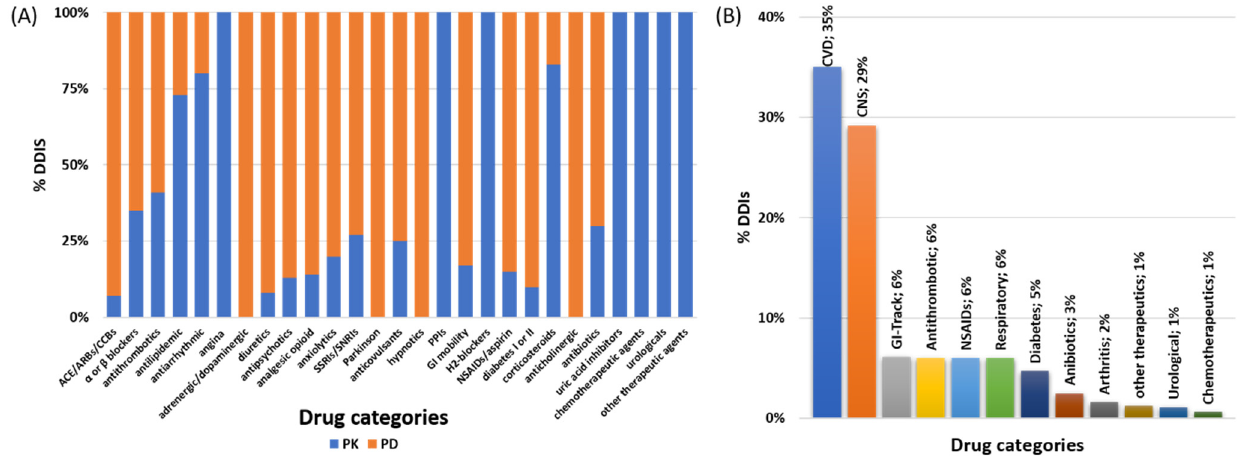
Figure 5. ( A ) PK-DDIS and PD-DDI distribution among medications and ( B ) overall drug categories that were involved in DDIs for the current study. (ACE: angiotensin-converting enzyme inhibitors; ARBs: angiotensin receptor blockers; CCBs: Ca 2+ channel blockers; GI: gastrointestinal system; NSAIDs: nonsteroidal anti-inflammatory drugs).